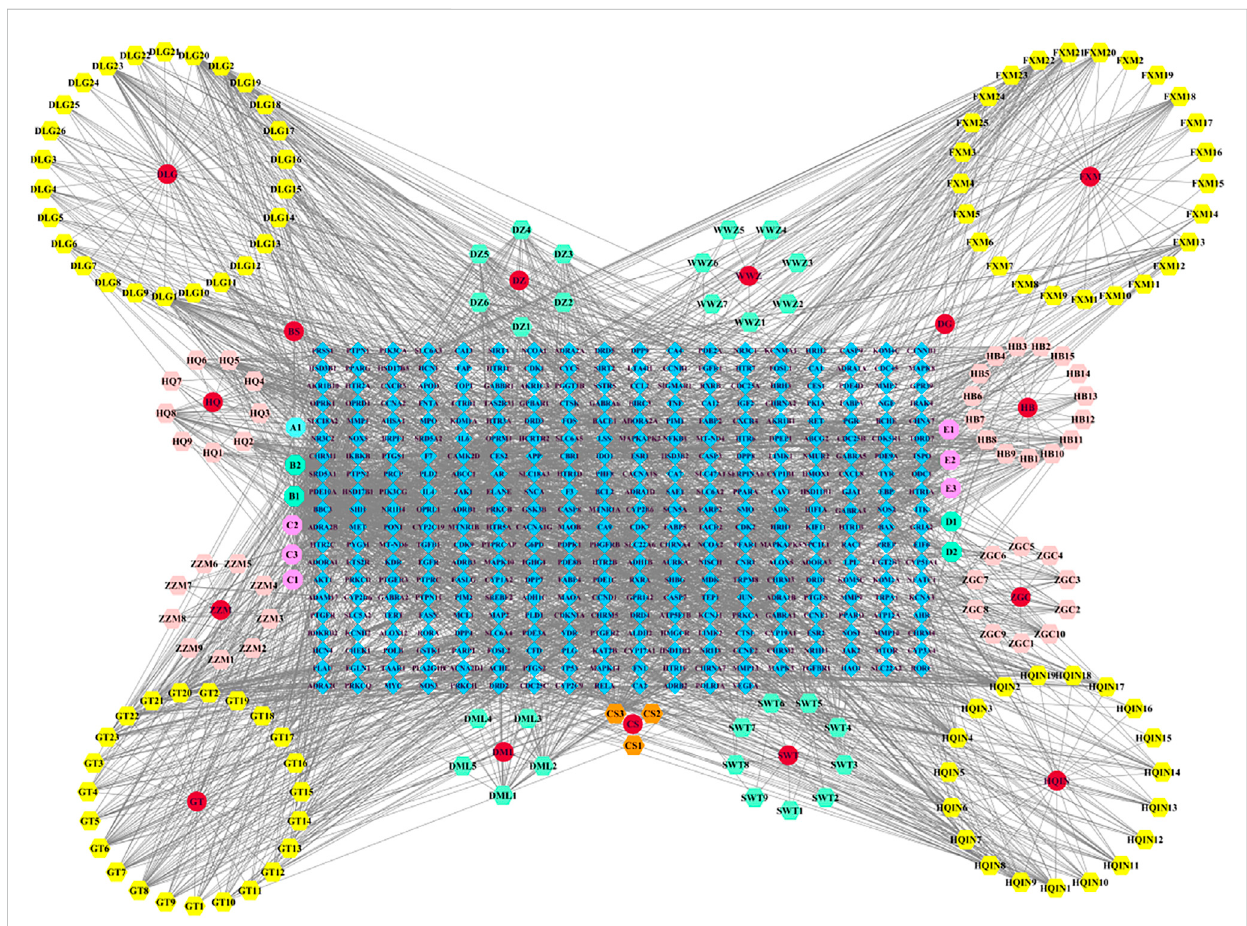
FIGURE 1 Chinese medicine-active ingredient-target network of LMQXM. The red circle nodes represent Chinese medicines; the regular hexagons represent the active ingredients; the regular octagons represent the common components between Chinese medicines; the blue diamond nodes represent the drug targets.